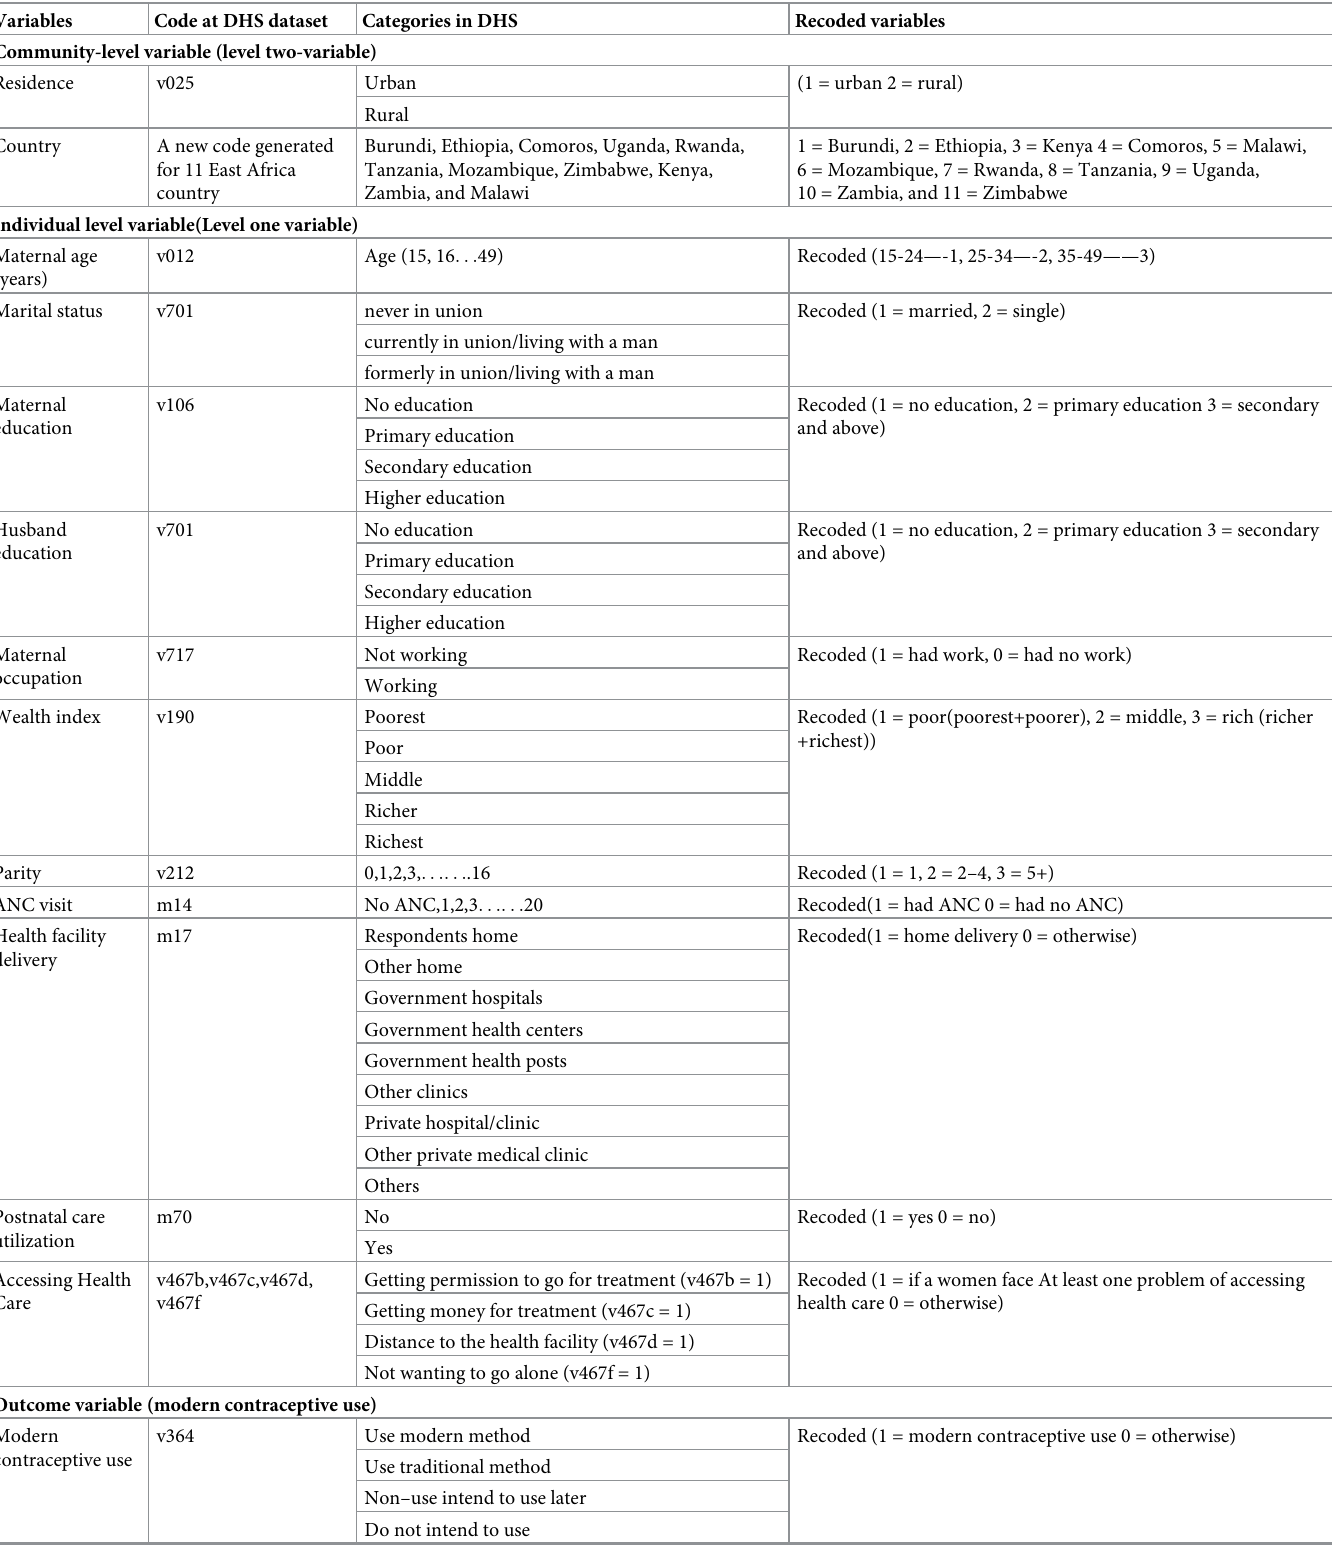
Table 1. Variable code and recode in the 11 East African country DHS